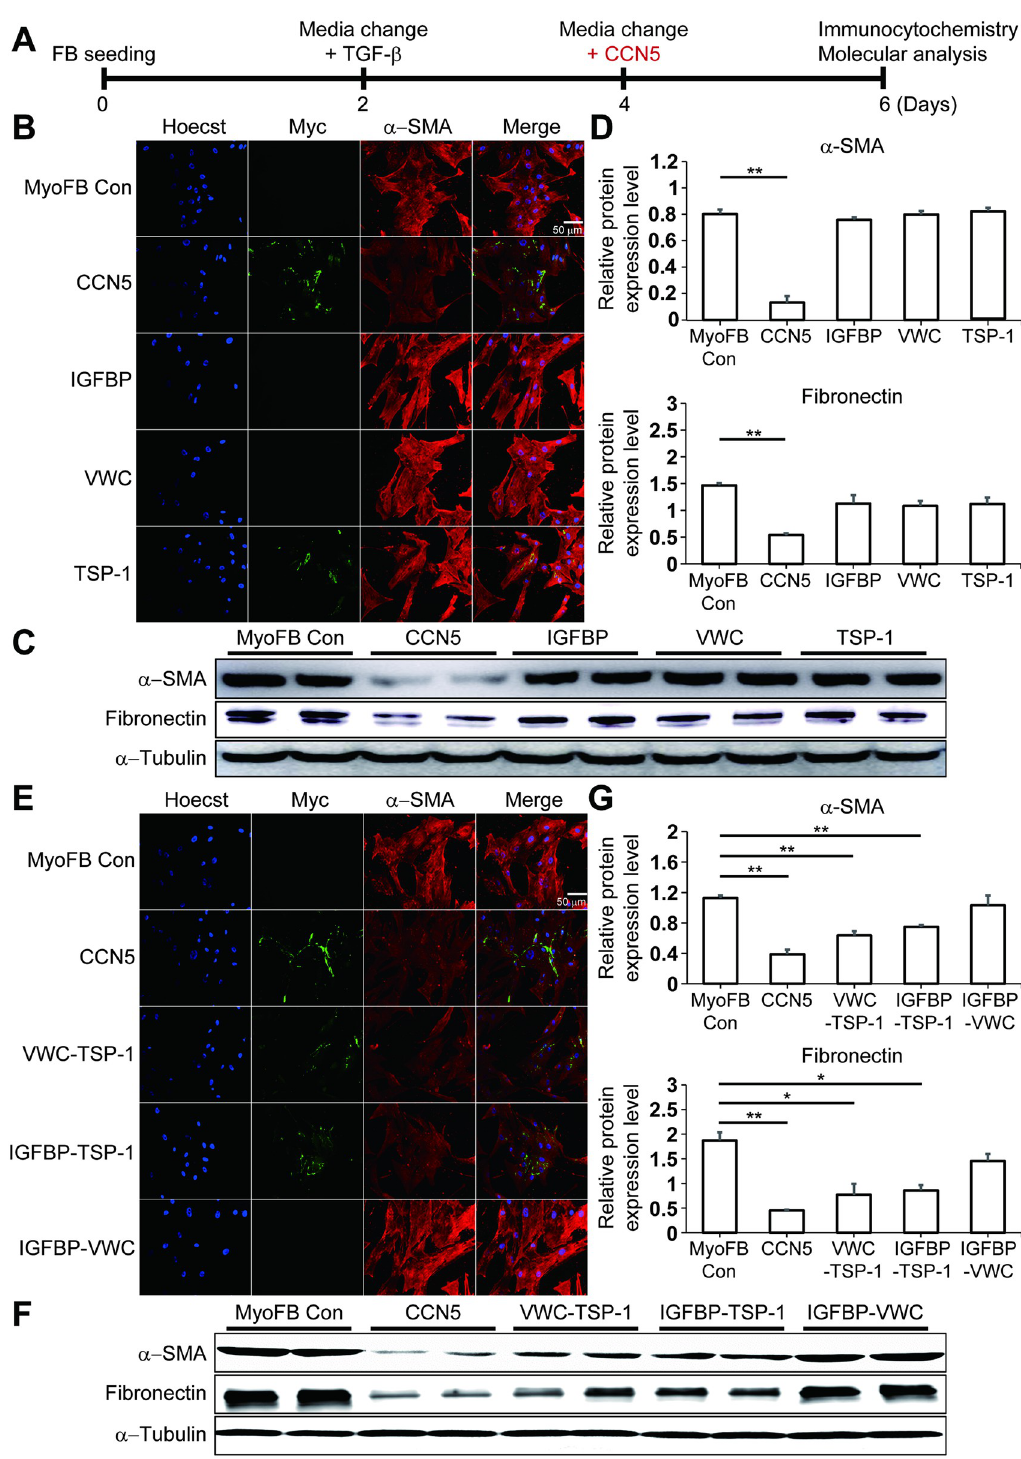
Fig 4. The TSP-1 domain is necessary but not sufficient for the function of CCN5. (A) The experimental scheme is shown. FBs were trans-differentiated to MyoFBs by treatment with TGF- β (10 ng/mL). MyoFBs were then treated for 2 days with purified CCN5 protein or with single domain or paired domains of CCN5 (20 nM). Cells were immunostained for Myc (CCN5), α -SMA, and nuclei were stained with Hoechst dye. (B, E) Representative images are shown. (C, F) Whole cell lysates (30 μ g) obtained from MyoFBs were immunoblotted with anti- α -SMA, -fibronectin, and - α -tubulin antibodies. (D, G) Protein bands on western blots were scanned and plotted. Scale bar: 50 μ m. n = 6.